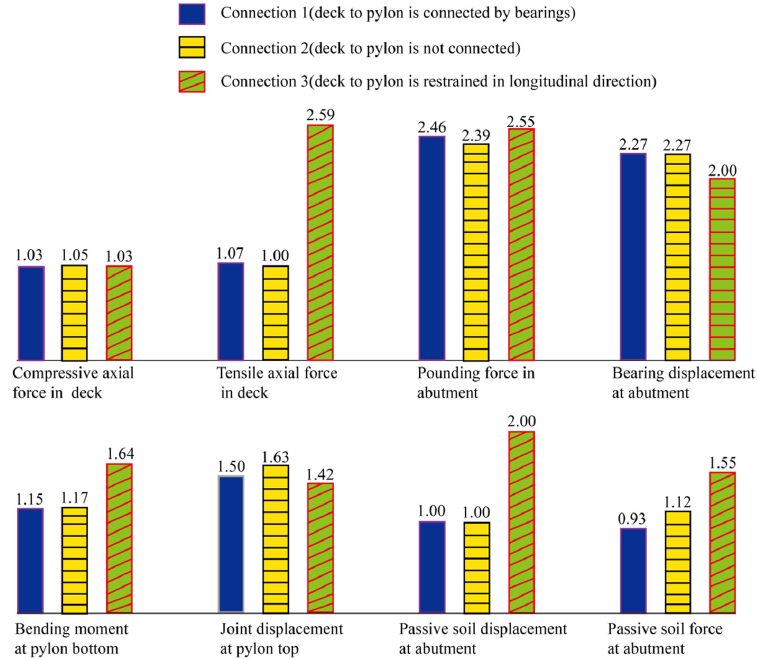
Figure 6. The ratios of the responses of the bridge with temperature change of ±35 °C to their counterparts with changing temperature of ±0 °C for different deck/pylon connections.